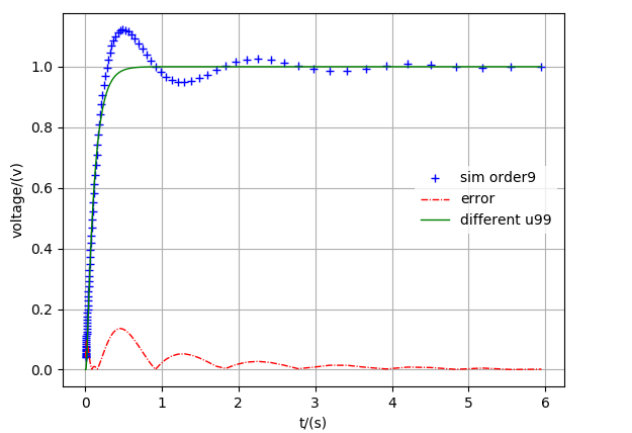
Figure 10. Simulation